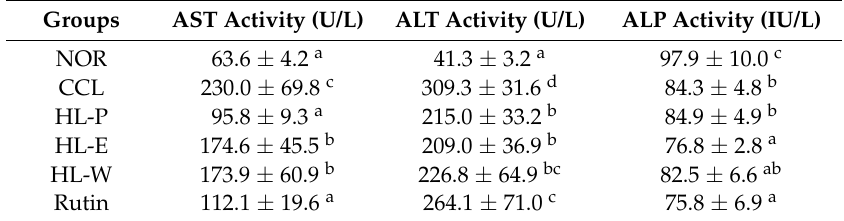
Table 3. The effects of red quinoa and its extracts on serum AST, ALT and ALP activities of the CCl 4 -induced liver injury mice.